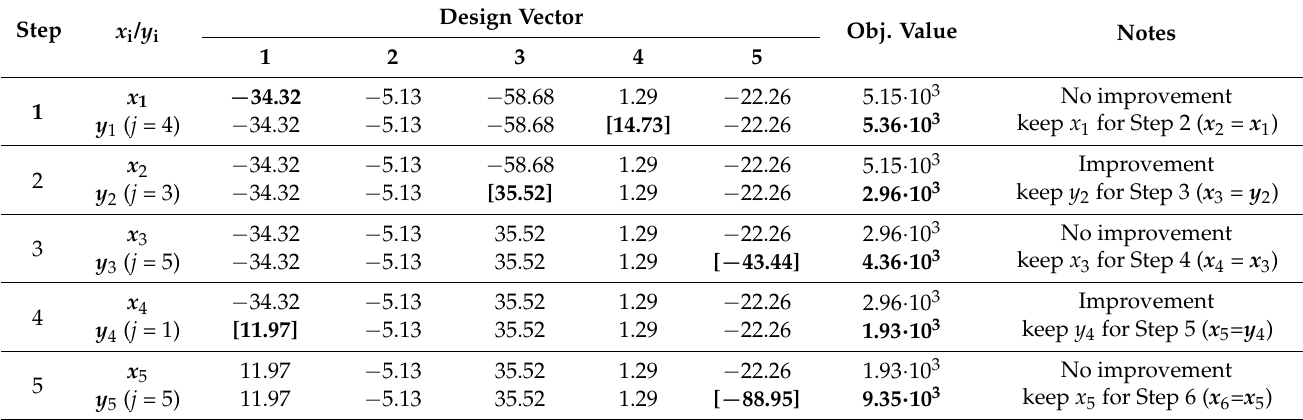
Table 1. Example case: the 5 first steps of the PROS algorithm for the F01-Sphere function (sphere_func) in [–100, 100] 2 .